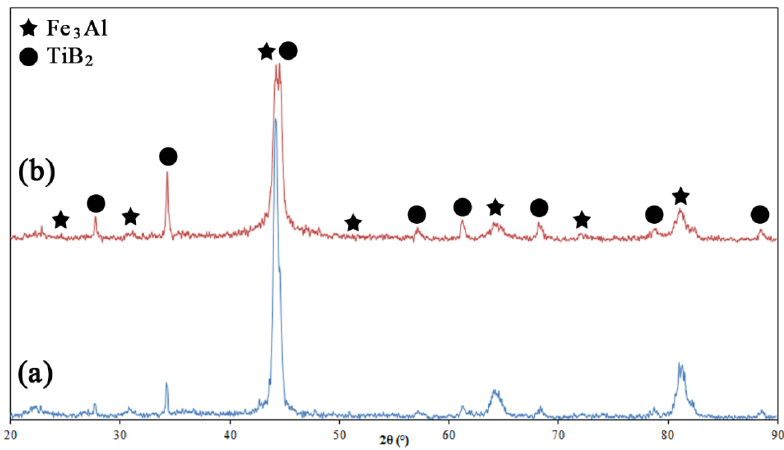
Figure 1. XRD patterns of the ( a ) Fe 3 Al ‐ 30 vol.% TiB 2 and ( b ) Fe 3 Al ‐ 50 vol.% TiB 2 HVOF composite coatings.